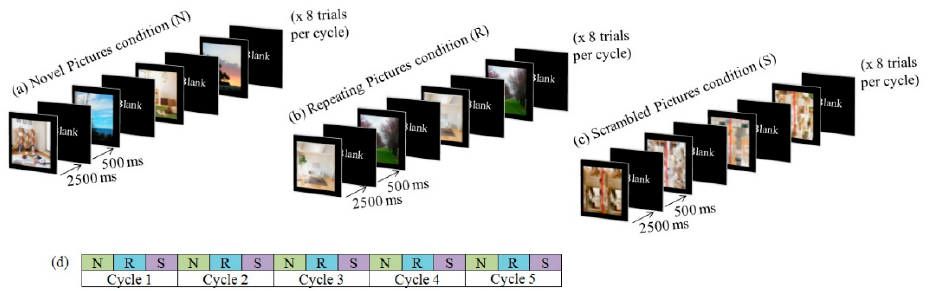
Figure 1. Stimulus presentation to each participant was blocked by the condition in the order of ( a ) Novel Pictures condition, ( b ) Repeating Pictures condition, and ( c ) Scrambled Pictures condition for 5 cycles. ( d ) Each block lasted 24 s and one run took 360 s in total.